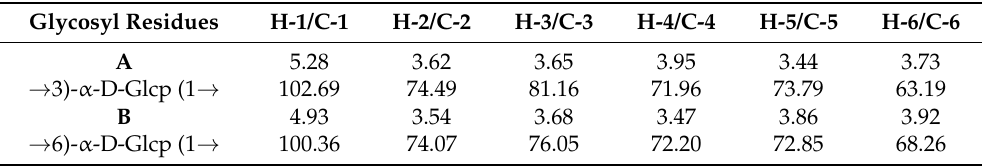
Figure 5. Scanning electron micrographs of EPS − 1 from Lc. citreum 1.2461. 400× ( A ), 1000× ( B ), 2000× ( C ) and 3000× ( D ).